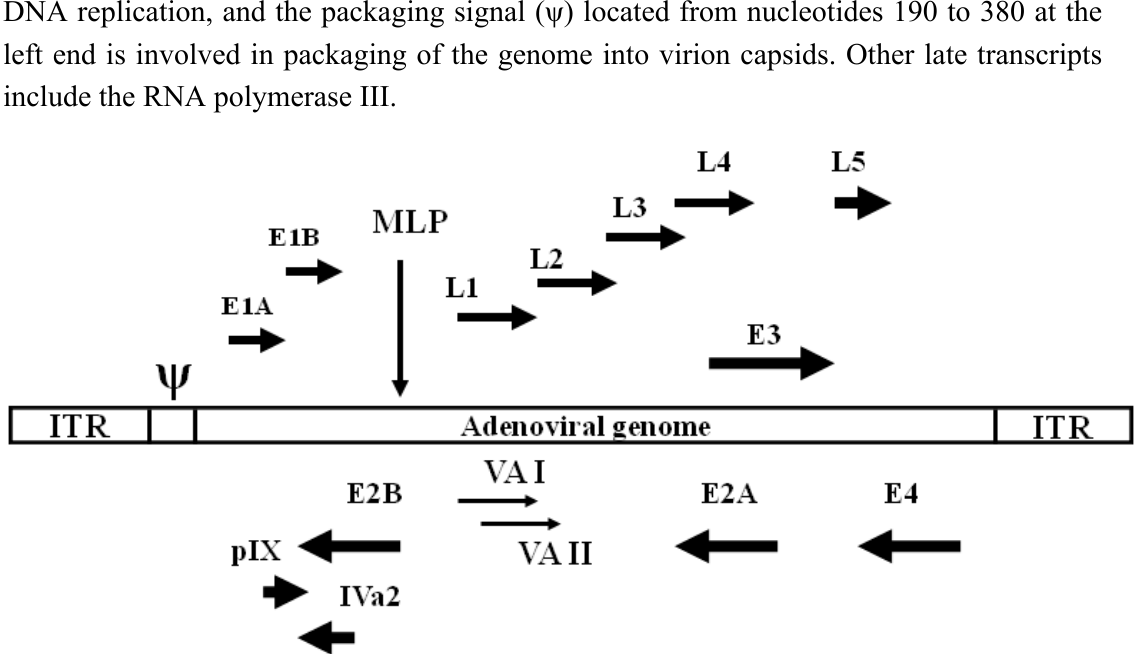
Figure 1 . Transcription map of human adenovirus serotype 5. The 100 map unit (~36